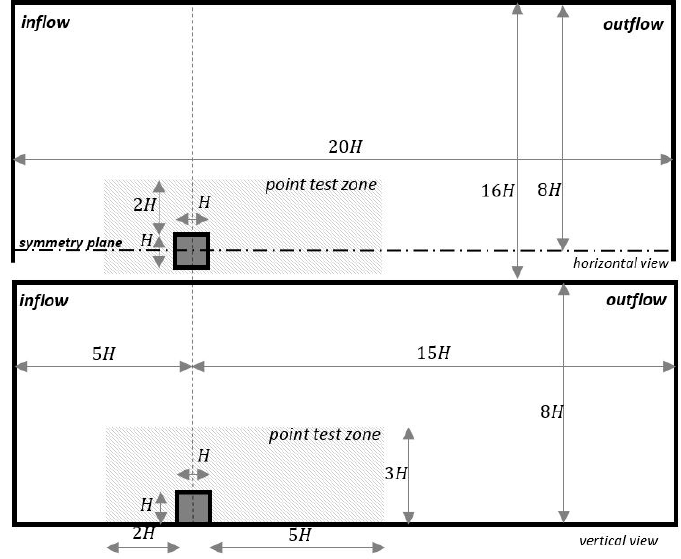
Figure 1. Sampling zone from the Blasius wind tunnel used by the “compilation of experimental data for validation purposes” (CEDVAL) project.